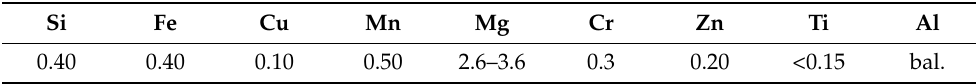
Table 1. AA6061 alloy chemical composition.